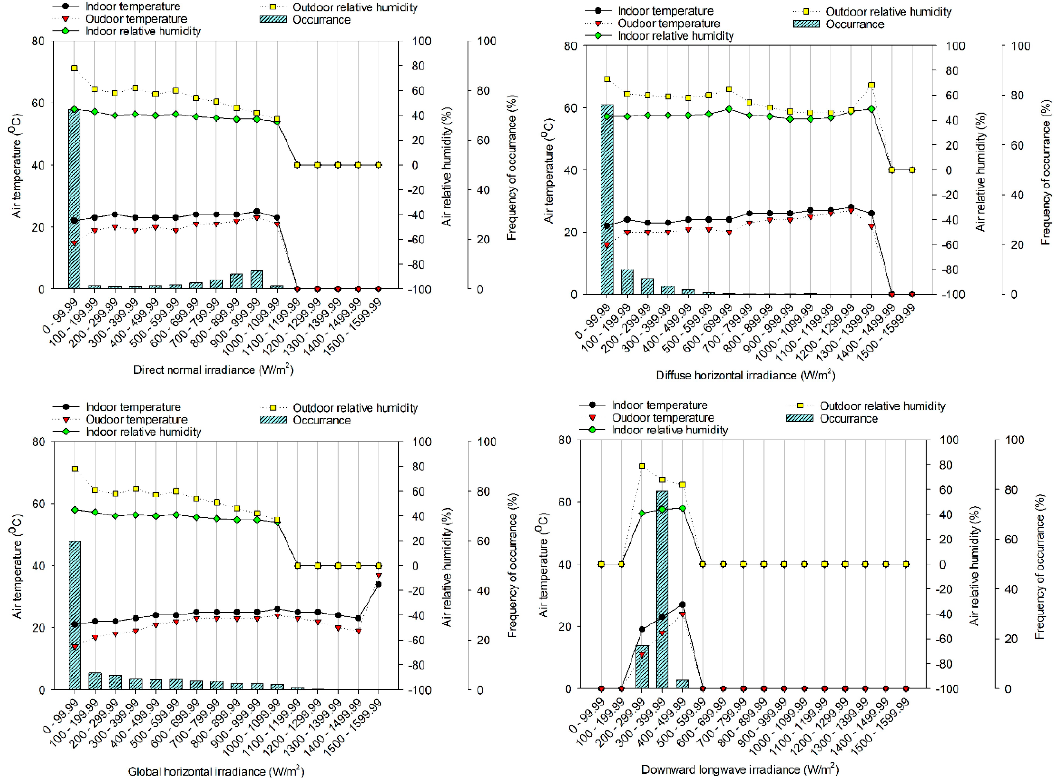
Figure 7. Indoor and outdoor thermal response to various components of solar radiation in summer.